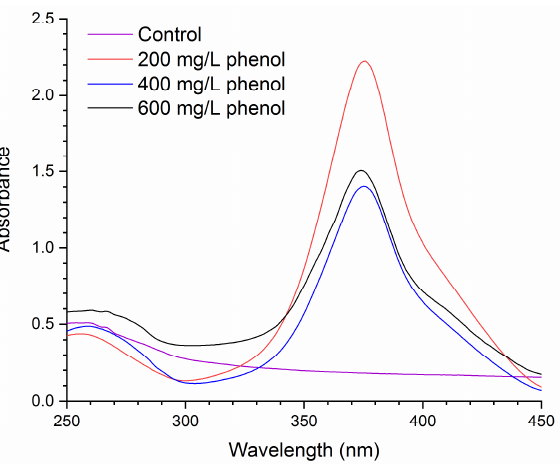
Figure 3. Detection of the catechol 2,3-dioxygenase activity in cell extracts of Pseudomonas sp. phDV1 grown under different concentrations of phenol. All sample spectra were recorded 6 min after the addition of catechol. Control spectrum was obtained in the absence of catechol.